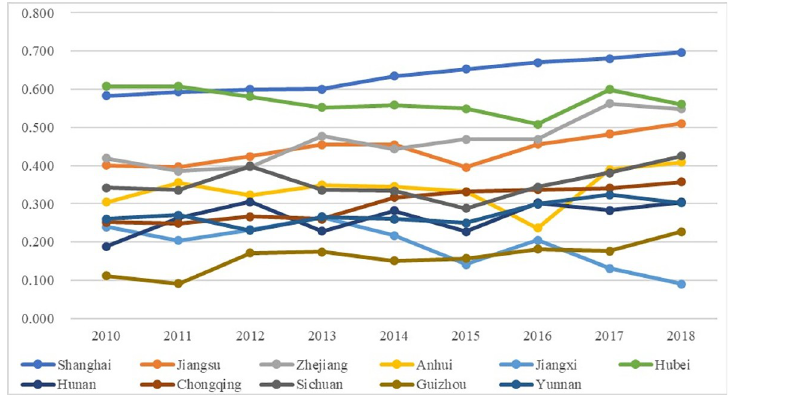
Fig 6. Overall performance of the science popularization